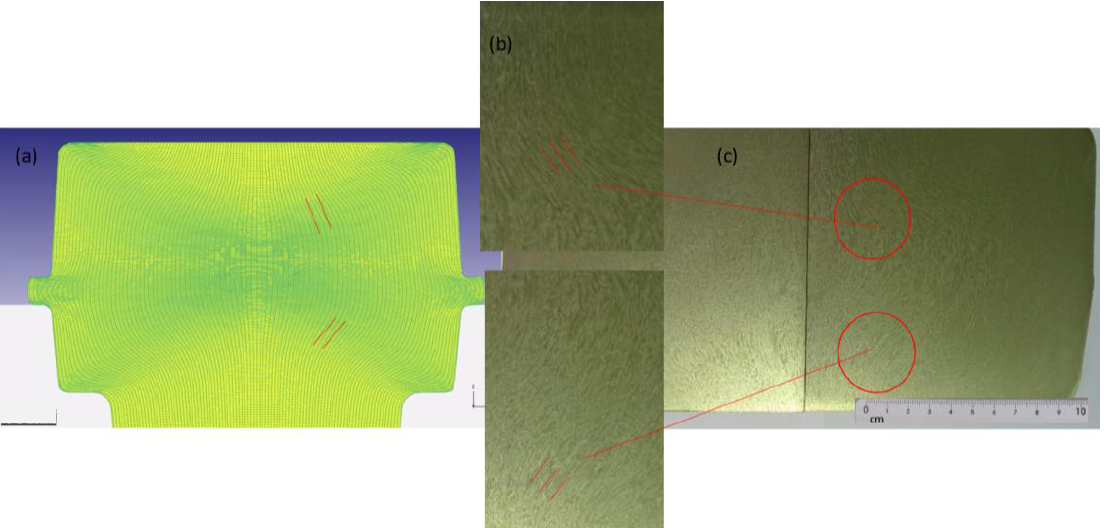
Figure 6. ( a ) Deformed grid pattern in the forging FEM simulation, ( b ) Metal flow pattern of the circled portion zoomed in, ( c ) Metallography of pinion shaft head after forging, showing metal flow lines.